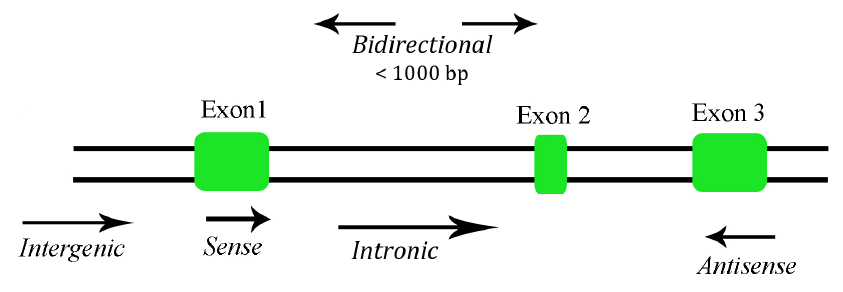
Figure 1. Categories of long non-coding RNA